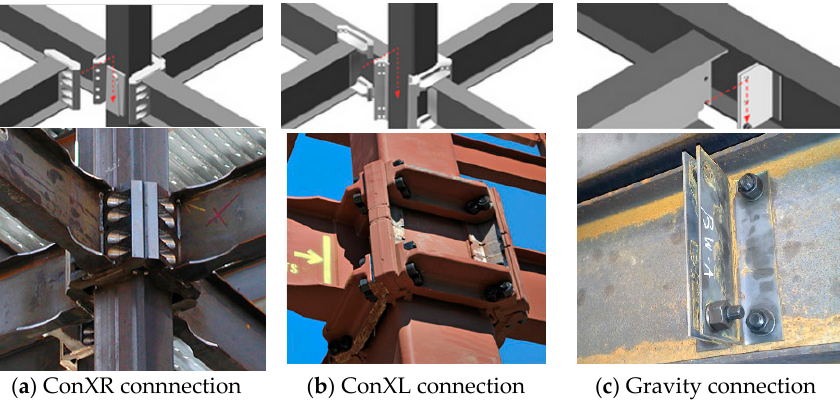
Figure 2. Types of connections from ConXtech (Source: ConXtech, used with permission from Kelly Luttrell).